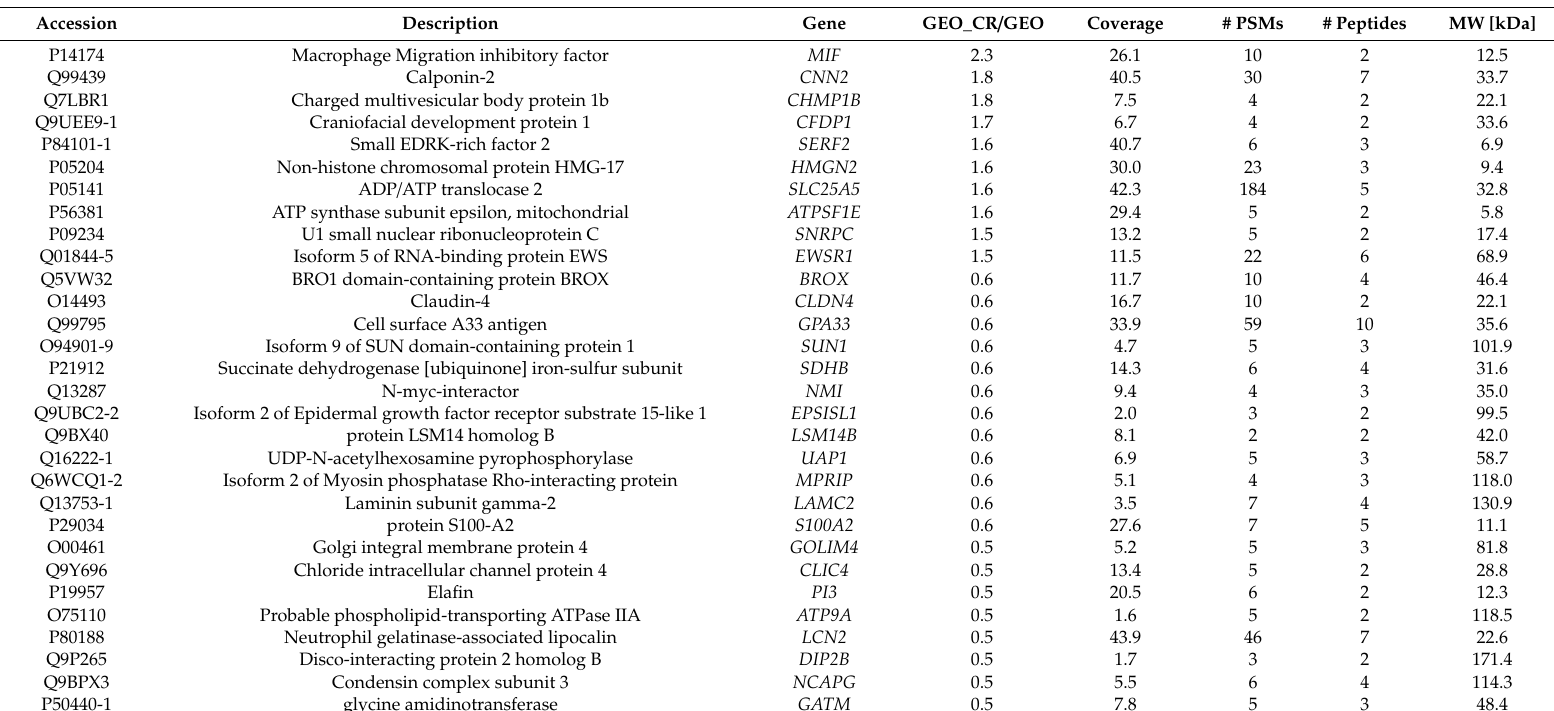
Table 1. Proteins di ff erentially regulated identified in cetuximab-resistant GEO cell lines by high-resolution LC-MS / MS. A total of 26 out of 2380 proteins were found to be di ff erentially expressed (0.6 ≥ FC ≥ 1.5) in cetuximab-resistant with respect to sensitive GEO cell